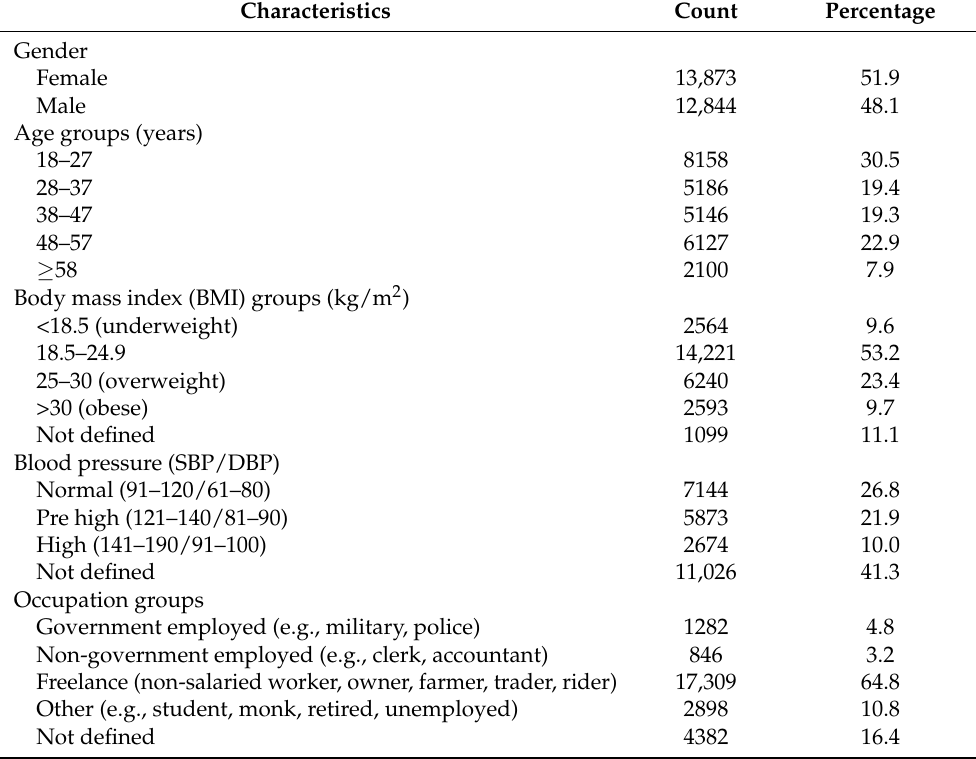
Table 1. Participant